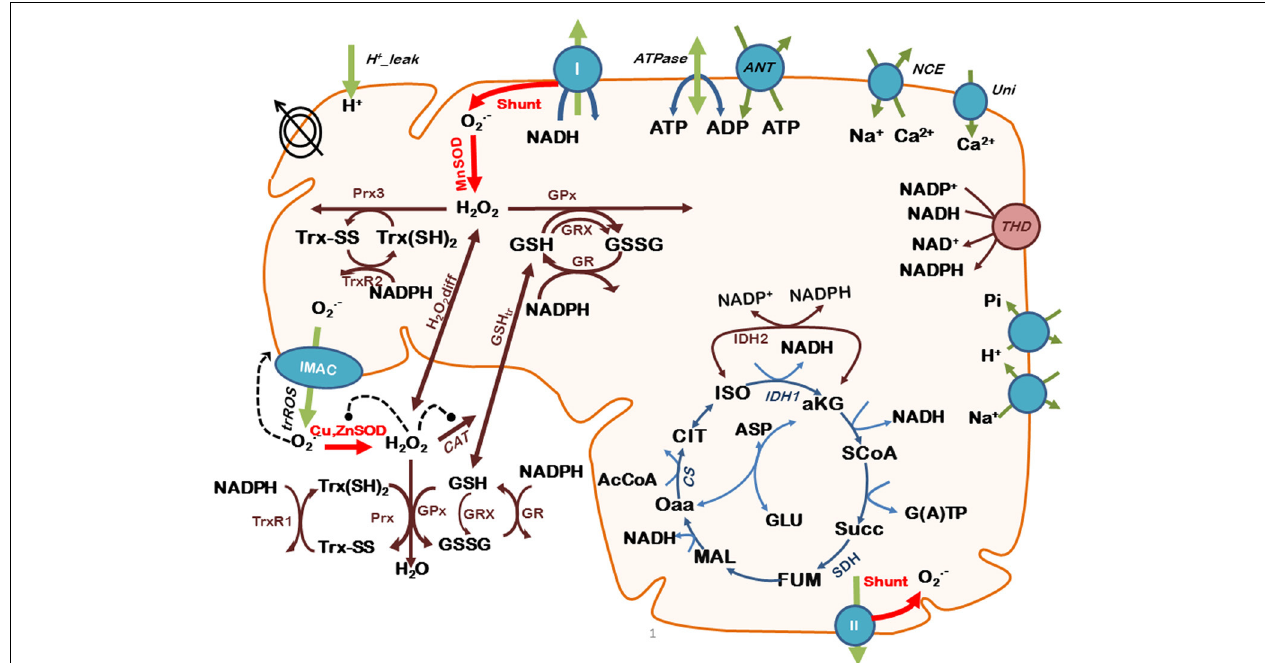
FIGURE 1 | Scheme of the two-compartment ME-R model accounting for mitochondrial energetic and redox processes, their interactions, and transport between compartments. The model takes into account oxidative phosphorylation (OxPhos) and matrix-based processes in mitochondria as well as in the extra-mitochondrial compartment. In addition to energy metabolism and ion transport (H + , Ca 2 + , Na + , Pi), the model accounts for O − 2 being produced in the mitochondrial electron transport chain from both complex I- and complex II-derived electron transport. O − 2 may be dismutated to H 2 O 2 by matrix-localized superoxide dismutase (MnSOD) or be transported to the extra-mitochondrial compartment through the inner membrane anion channel (IMAC), where